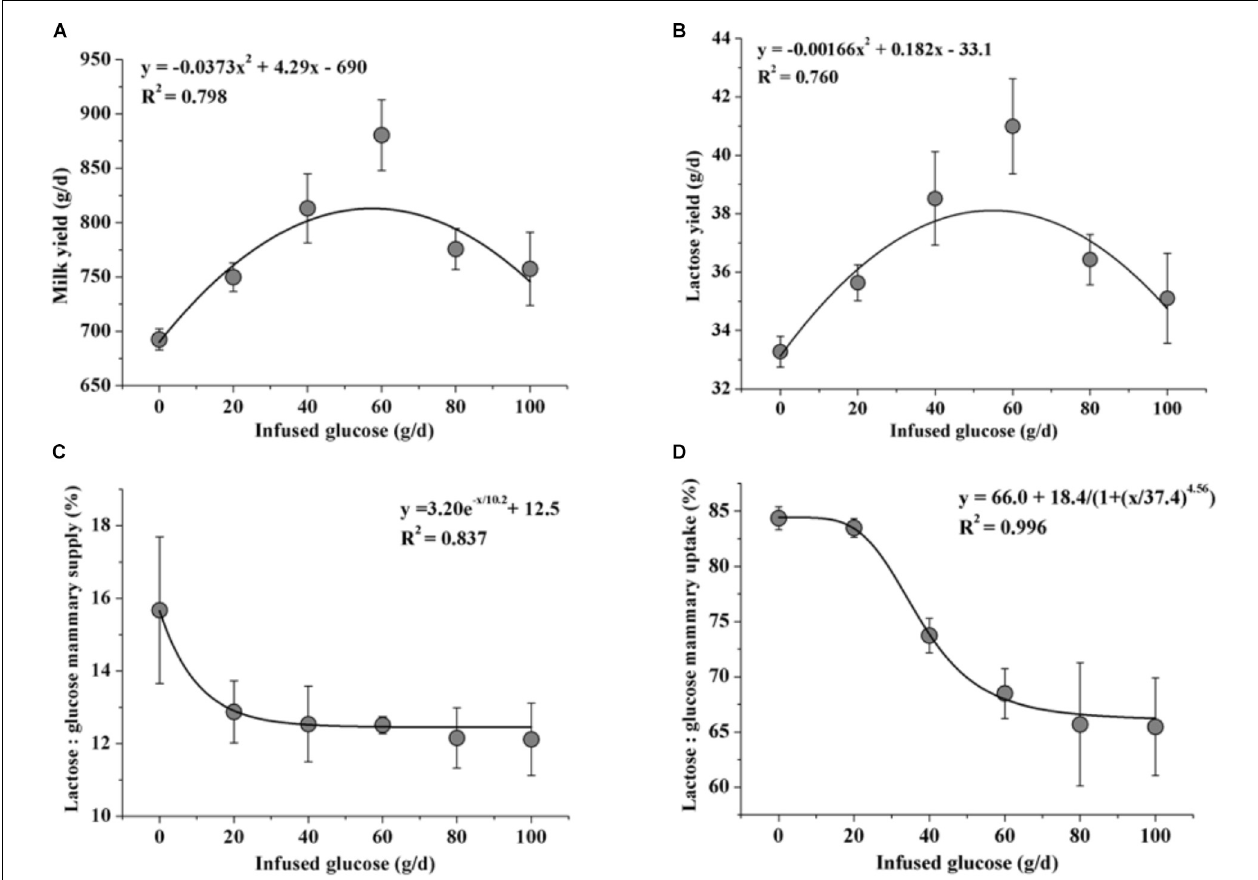
FIGURE 6 | Fitting curves of milk production [milk yield (A) and lactose yield (B) ] and glucose utilization [the ratio of lactose yield and glucose mammary supply (C) and the ratio of lactose yield and glucose mammary uptake (D) ] when 0–100 g/d of glucose was infused to the mammary gland. Error bar represents standard error.